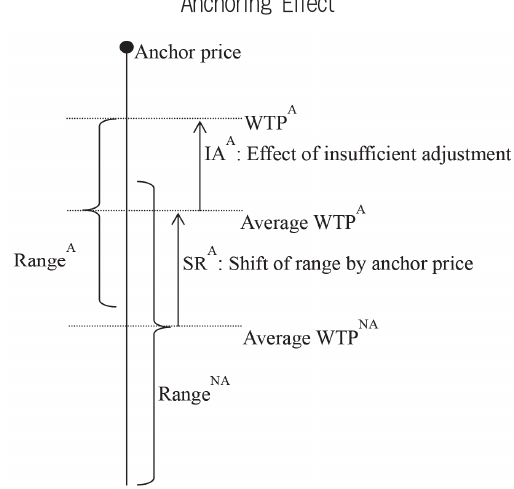
<Figure 2> Conceptual Presentation of the Anchoring